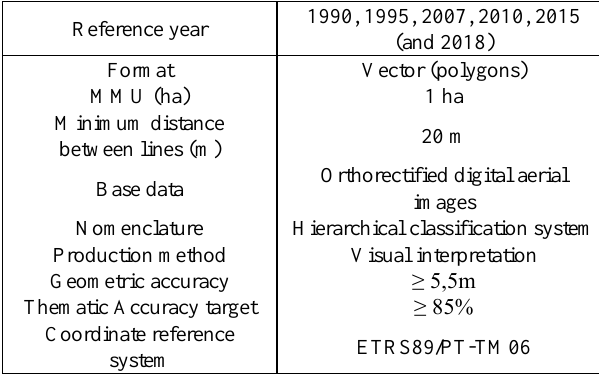
Table 1. Technical specifications of COS Figure 2. Methods used detecting vegetation